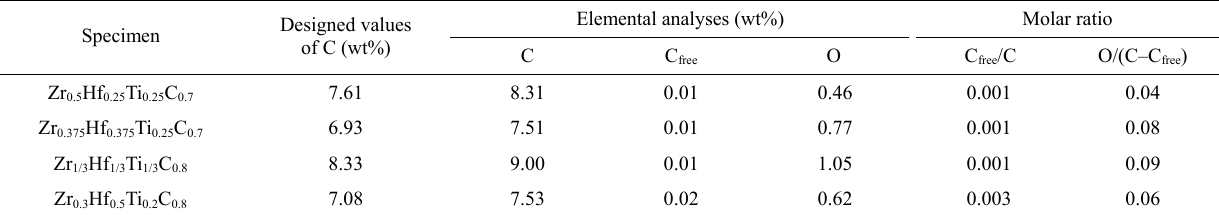
Table 2 Elemental analyses data of